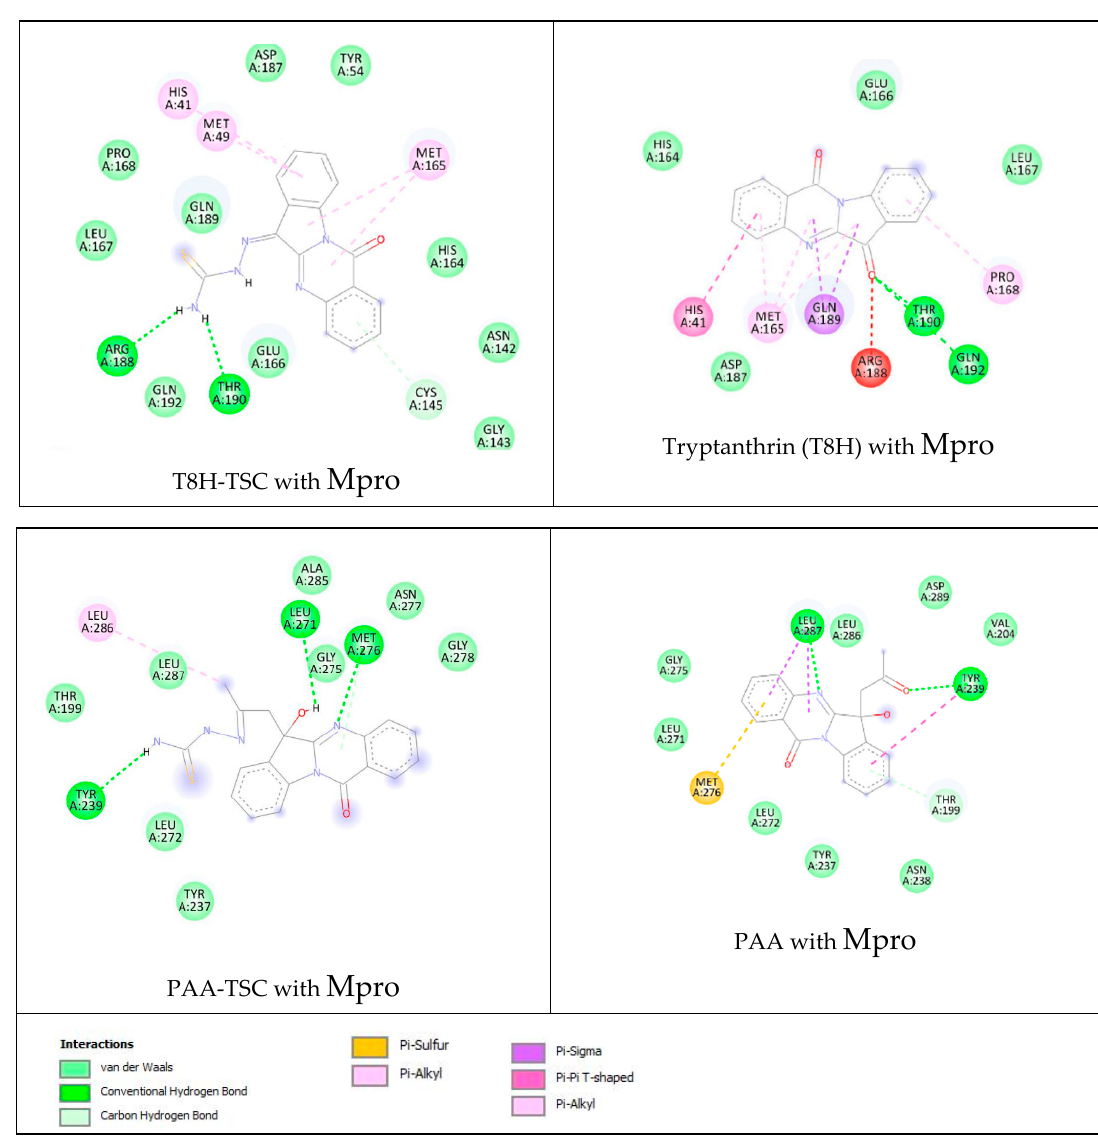
Figure 19. Comparison of 2D diagrams of interactions complexes Mpro with traptanthrin derivates (TSC compounds, the left side of figure) with tryptanthrin and PAA (right).